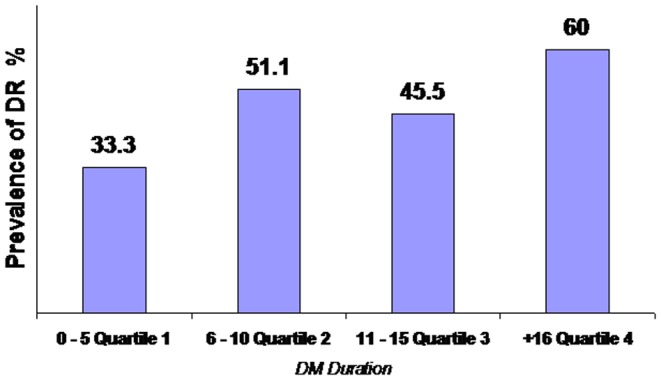
Distribution of DR across the quartiles of DM duration.